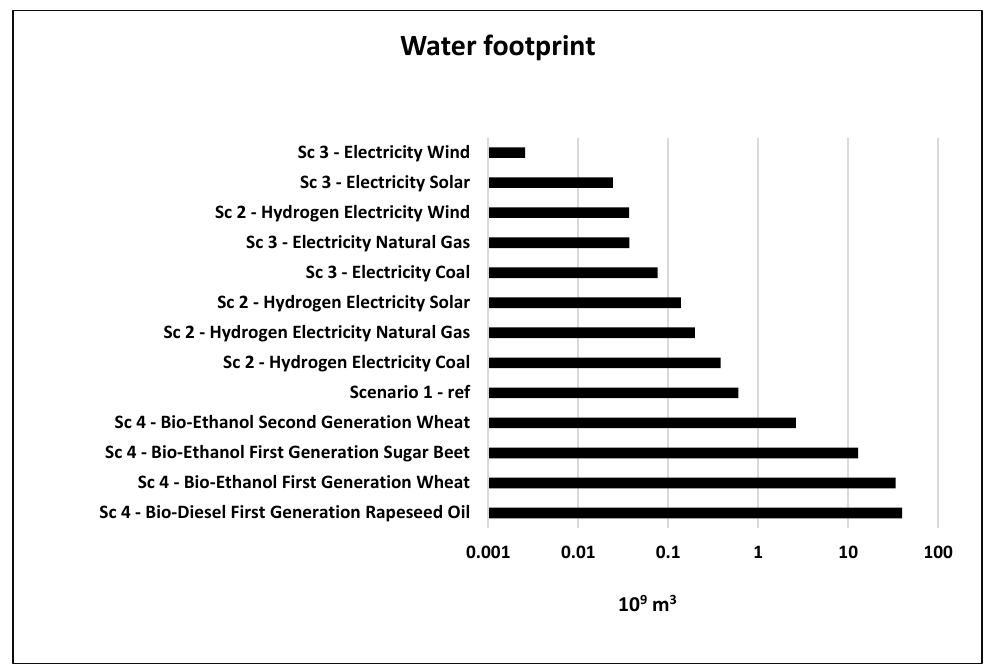
Figure 9. Annual water footprint of the four scenarios for transport fuels in the Netherlands, including the reference scenario for fuel use in 2016 (10 9 m 3 logarithmic scale).